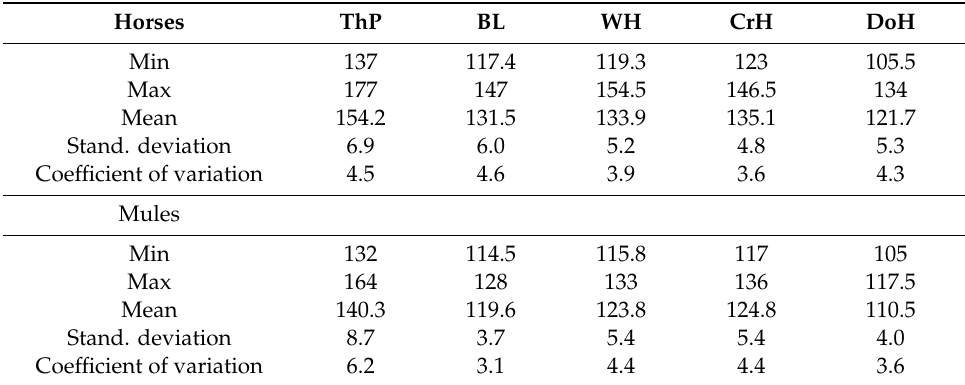
Table 3. Main descriptive statistics for traits which were significatively di ff erent between horses ( n = 150) and mules ( n = 15) ( p < 0.001). See text for acronyms. Lineal values in cm. Coe ffi cient of variation in